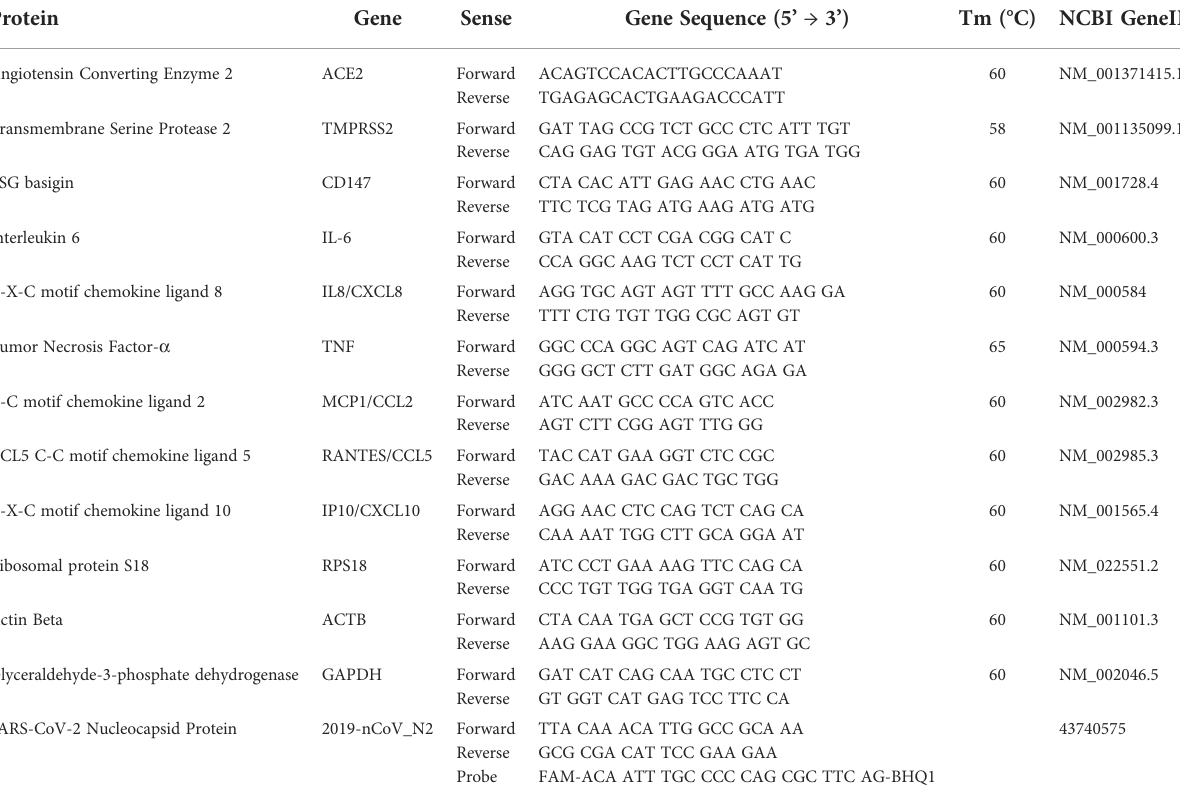
TABLE 2 Primer sequences used for